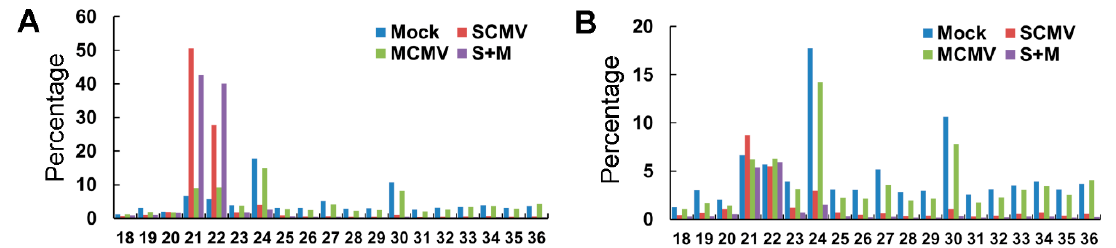
Figure 1. Size distribution of small RNAs from Mock-, SCMV-, MCMV-, and S + M-inoculated maize plants. ( A ) Size distribution of total reads of small RNAs from Mock-, SCMV-, MCMV-, and S + M-inoculated maize plants. ( B ) Size distribution of total reads of small RNAs (without vsiRNAs) from Mock-, SCMV-, MCMV-, and S + M-inoculated maize plants.